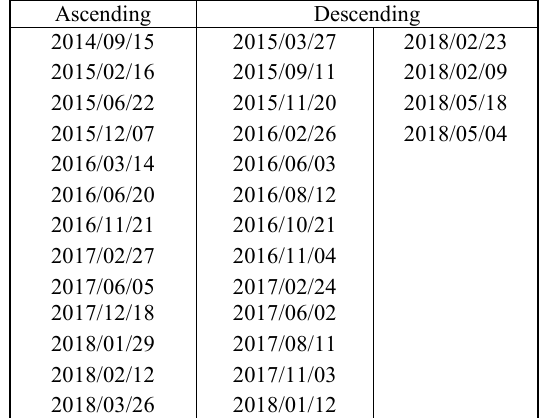
Figure 2. Matching of PS and GNSS points, represented by blue and red circles, respectively.